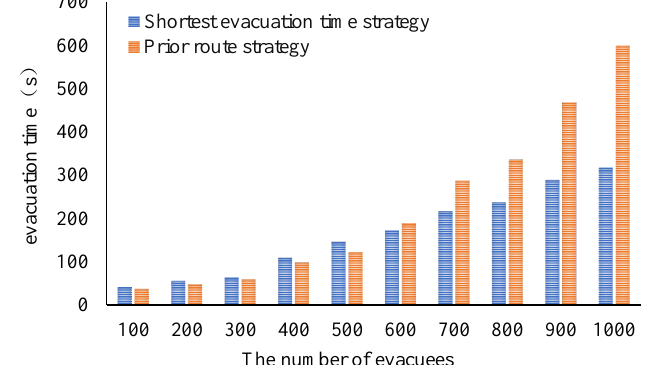
Figure 13. Relationship between evacuees and evacuation